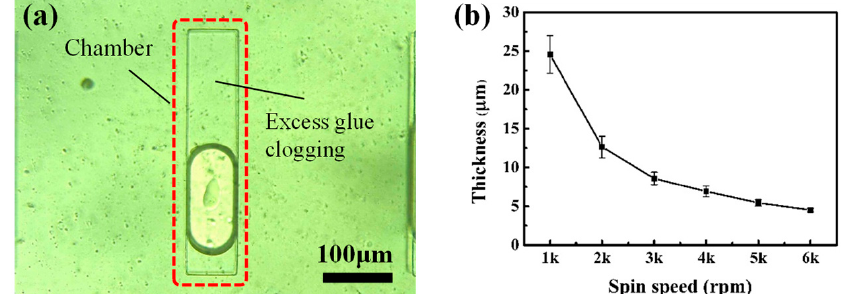
Figure 5. ( a ) Chamber clogging caused by adhesive overflow; ( b ) the spin speed–thickness curve of adhesive NOA 81.